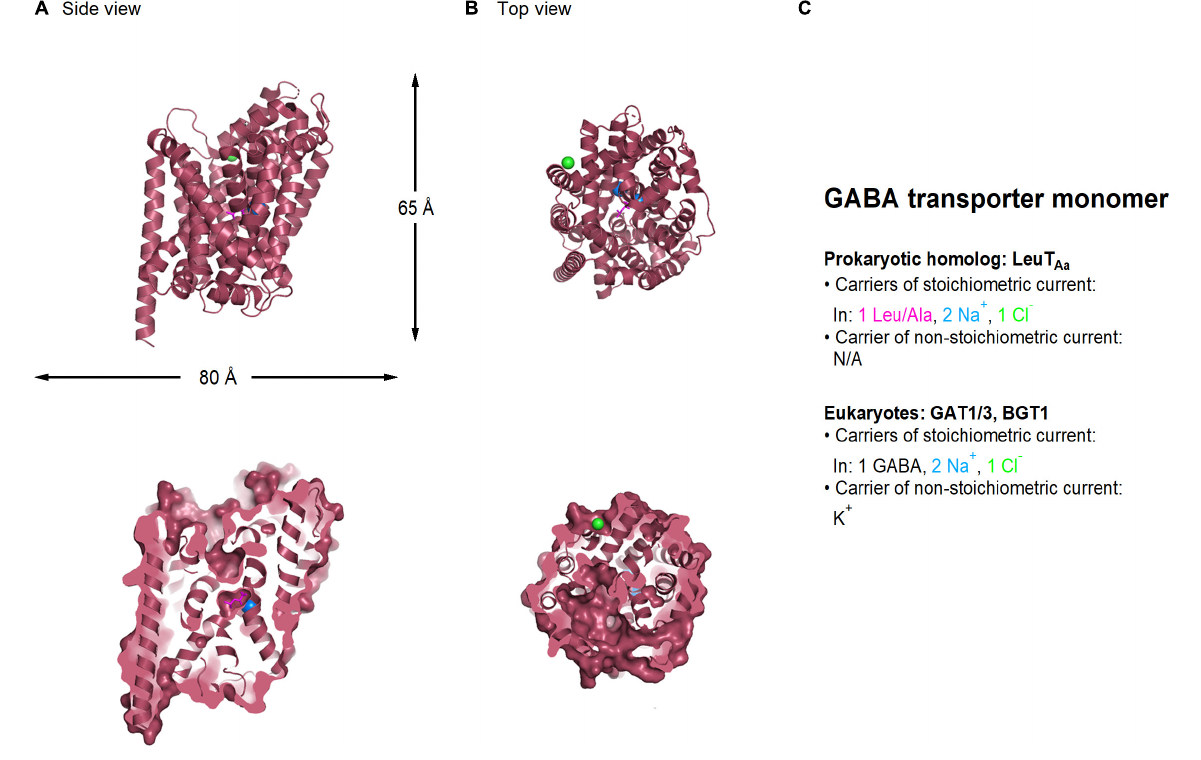
FIGURE 2 | Crystal structure of LeuT AA , a bacterial homolog of GABA transporters (PDB: 2A65). (A) Side view of the LeuT Aa transporter parallel to the membrane, using a ribbon ( top ) and a surface representation sliced through the center of the transporter ( bottom ). (B) As in (A) , viewed from the extracellular side of the membrane. Leu ( magenta ), sodium ( blue ), and chloride ions ( green ) are represented as spheres. (C) Summary of the main feature of the stoichiometric and non-stoichiometric current mediated by Leu and GABA transporters in prokaryotes and eukaryotes, respectively. Image generated using The PyMOL Molecular Graphics System (Version 2.3.2; Schrödinger,